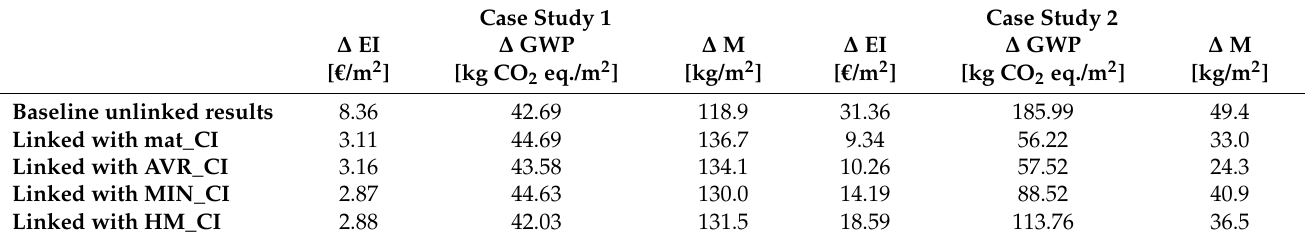
Table 8. Difference ( ∆ ) between the variants with the highest and lowest EI, GWP or M per case study, in absolute values. Case Study